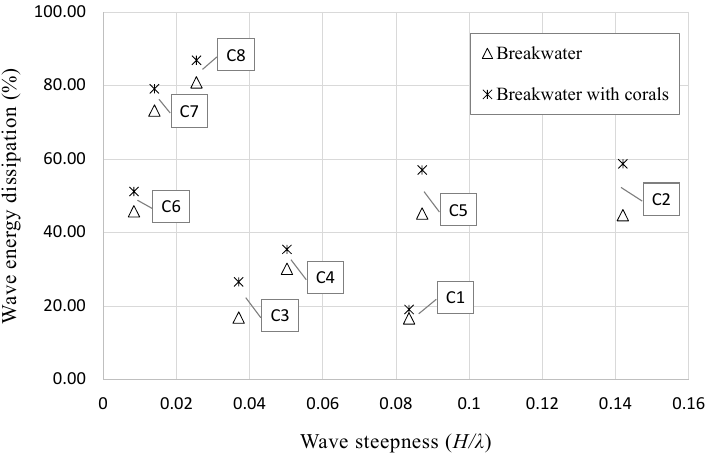
Figure 8. Wave-energy dissipation for the two configurations of the reef model under a water depth h = 0.65m.